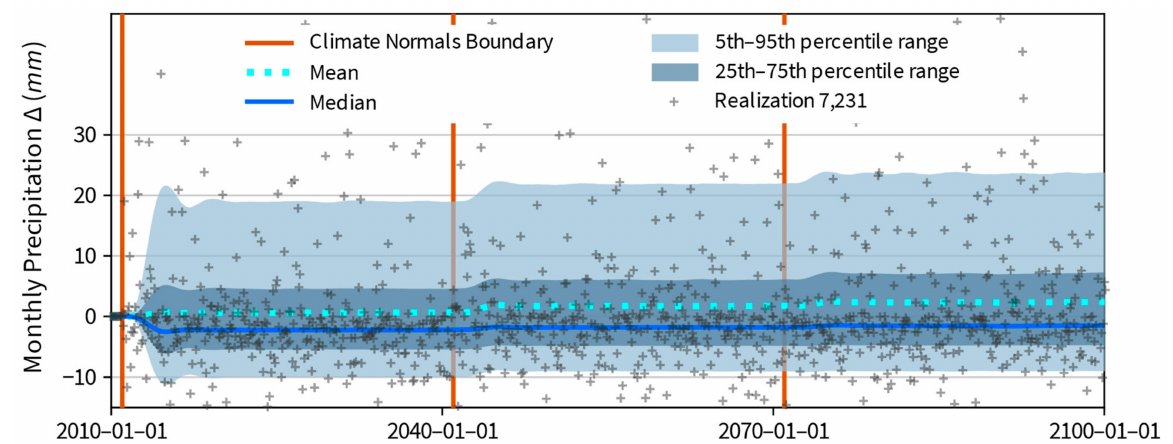
Figure 6. Probabilistic description of projected future changes in precipitation amount. These results are from the CC scenario in Table 1 where the framework is used to compare future climate trends to historical conditions. Results from a single realization are plotted to elucidate the differences between realization values and probabilistic time histories. Adapted from Martin [19] CC BY